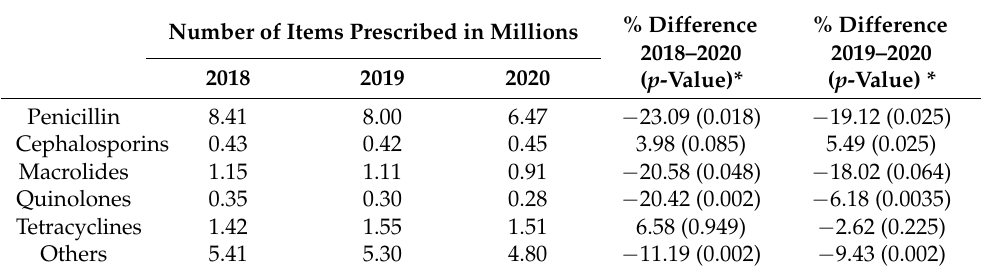
Table 3. Number of antibiotics prescribed (in millions) as per pharmacological class of antibiotics between March and September of the respective